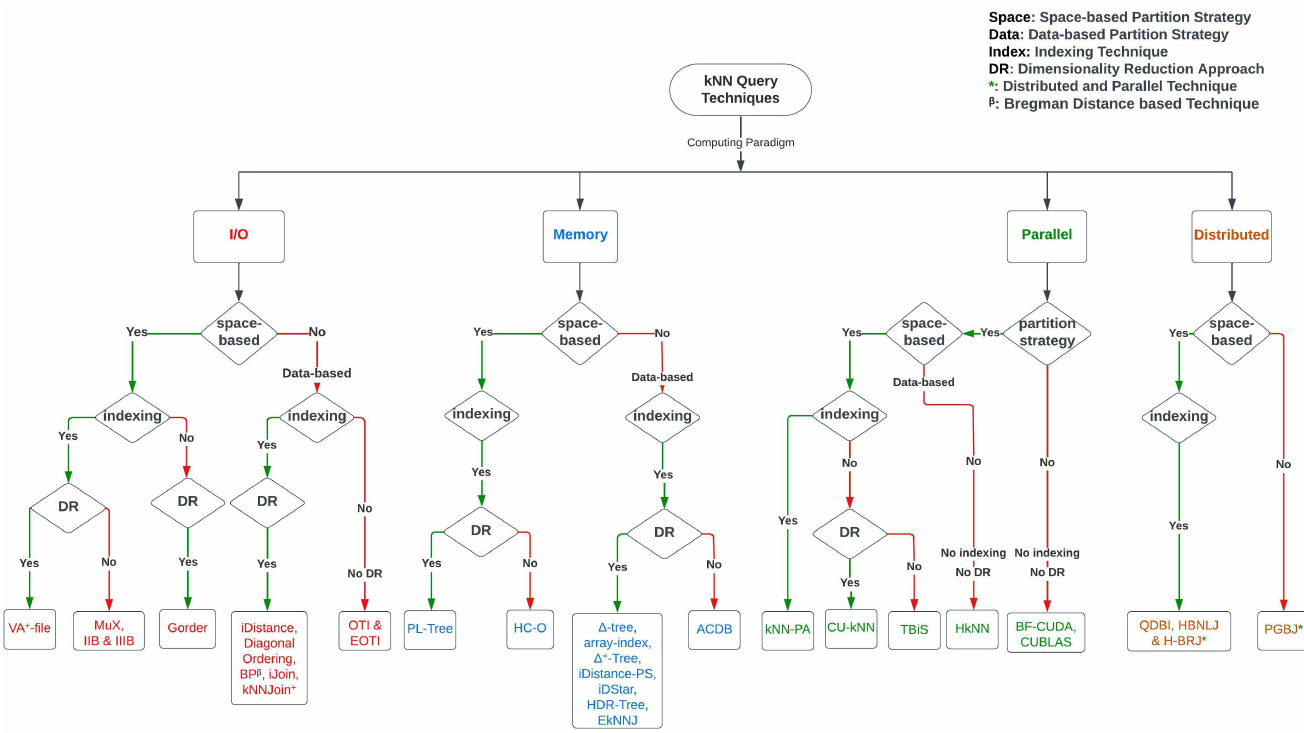
Figure 4. Block flow diagram of kNN query techniques based on the different classification